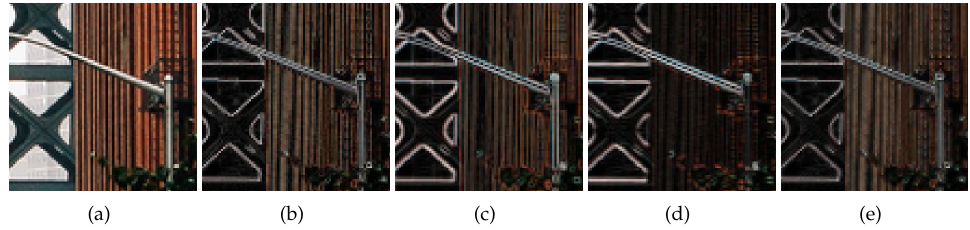
Figure 3. Normalized weights map examples, ( a ) GT, ( b ) Using forward difference for two directions and L2 norm, ( c ) Using Sobel filtering and L1 norm, ( d ) Using forward difference for two directions and L1 norm, ( e ) Using forward difference for four directions and L1